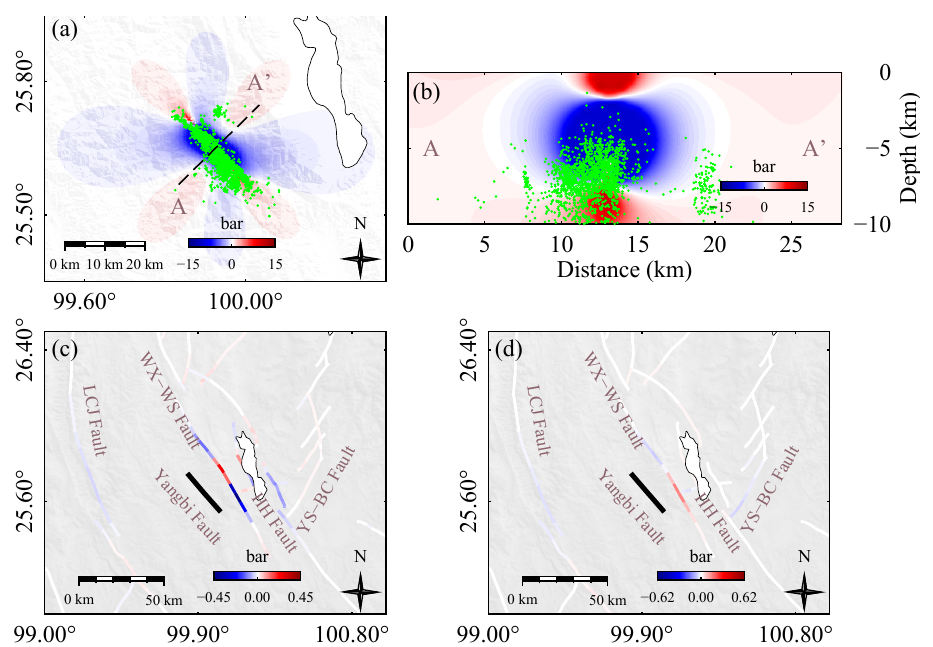
Figure 7. Static CFS changes resulting from the Yangbi event. ( a ) CFS change field at the depth of 5 km. The line AA’ shows the surface position of the ( b ) profile. ( b ) CFS change along the AA’ profile. ( c ) CFS change at the depth of 5 km for right-lateral slip on nearby faults; where ( d ) is the same as ( c ) but for normal slip.